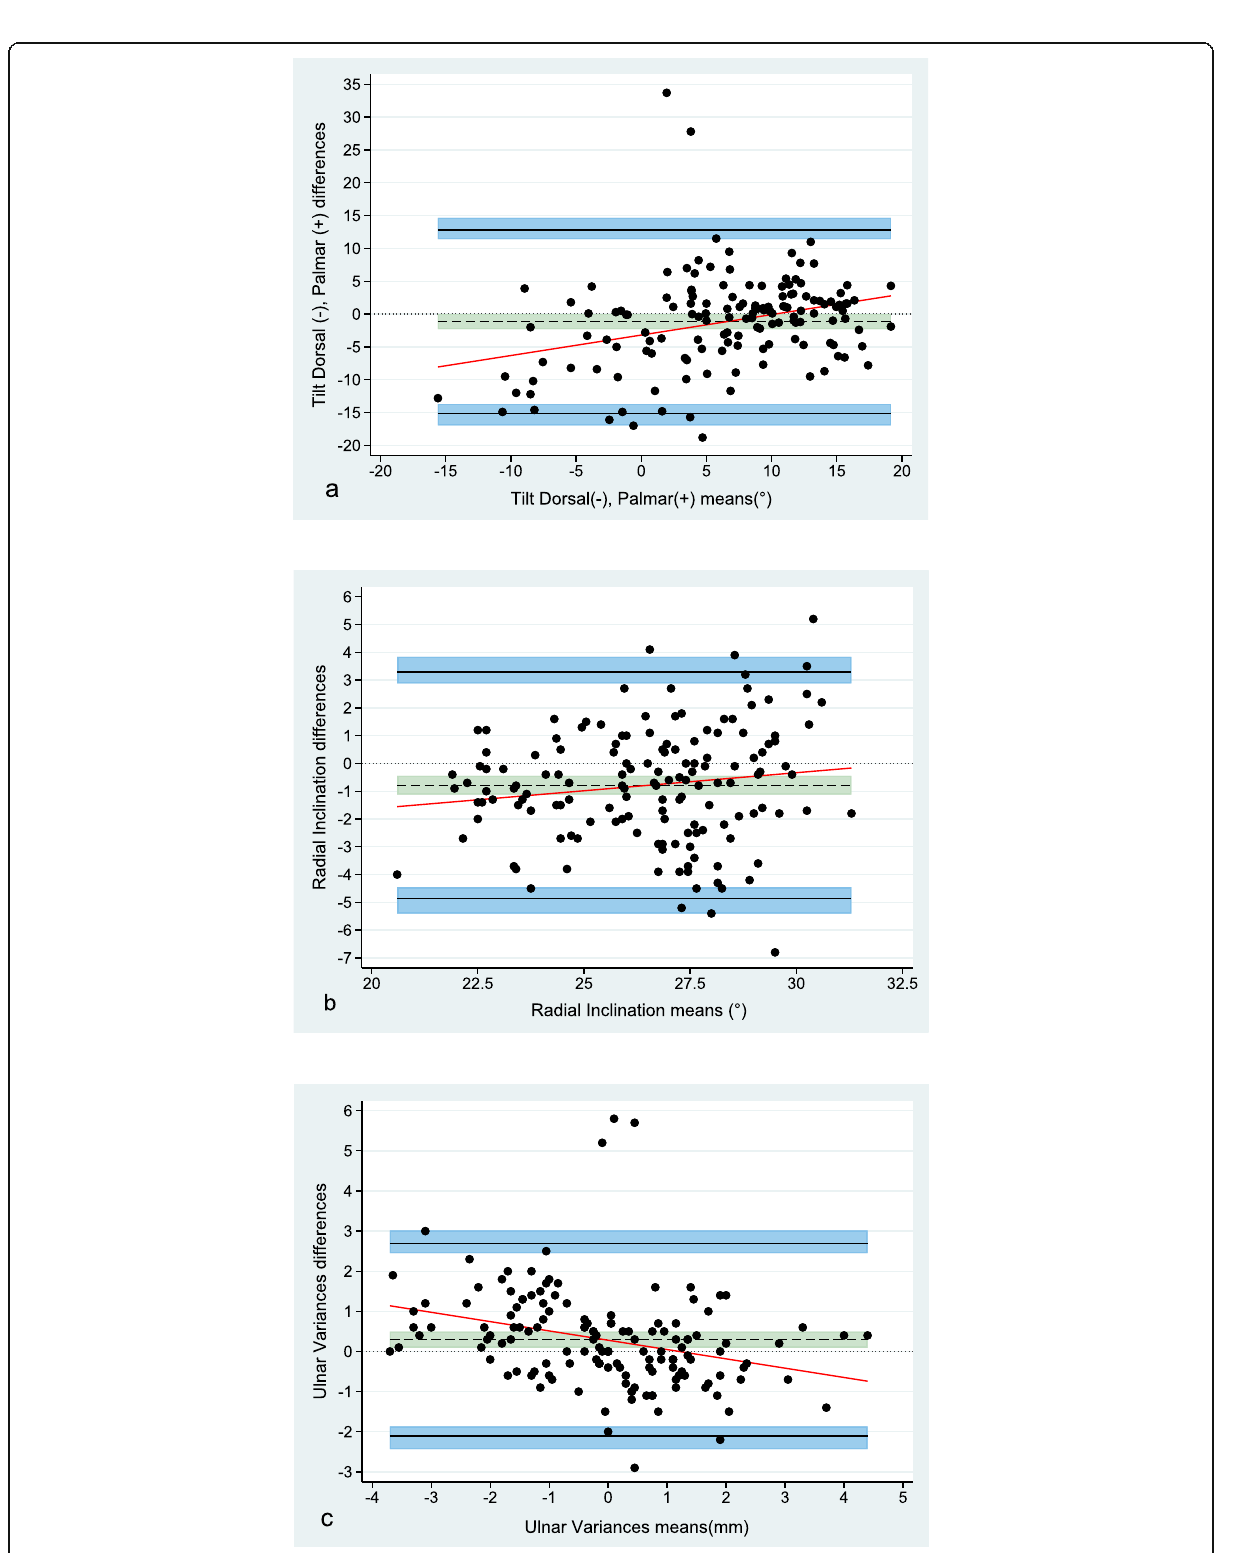
Fig. 5 Bland-Altman plots displaying interobserver agreement (147 images). Differences between measurements are plotted against the mean of the measurements for tilt ( a ), radial inclination ( b ), and ulnar variance ( c ),